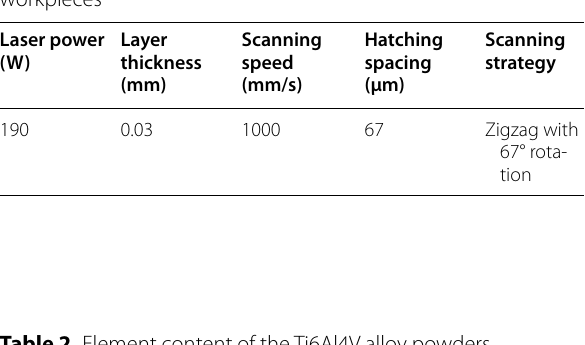
Table 2 Element content of the Ti6Al4V alloy powders Element Al V Fe O Ti